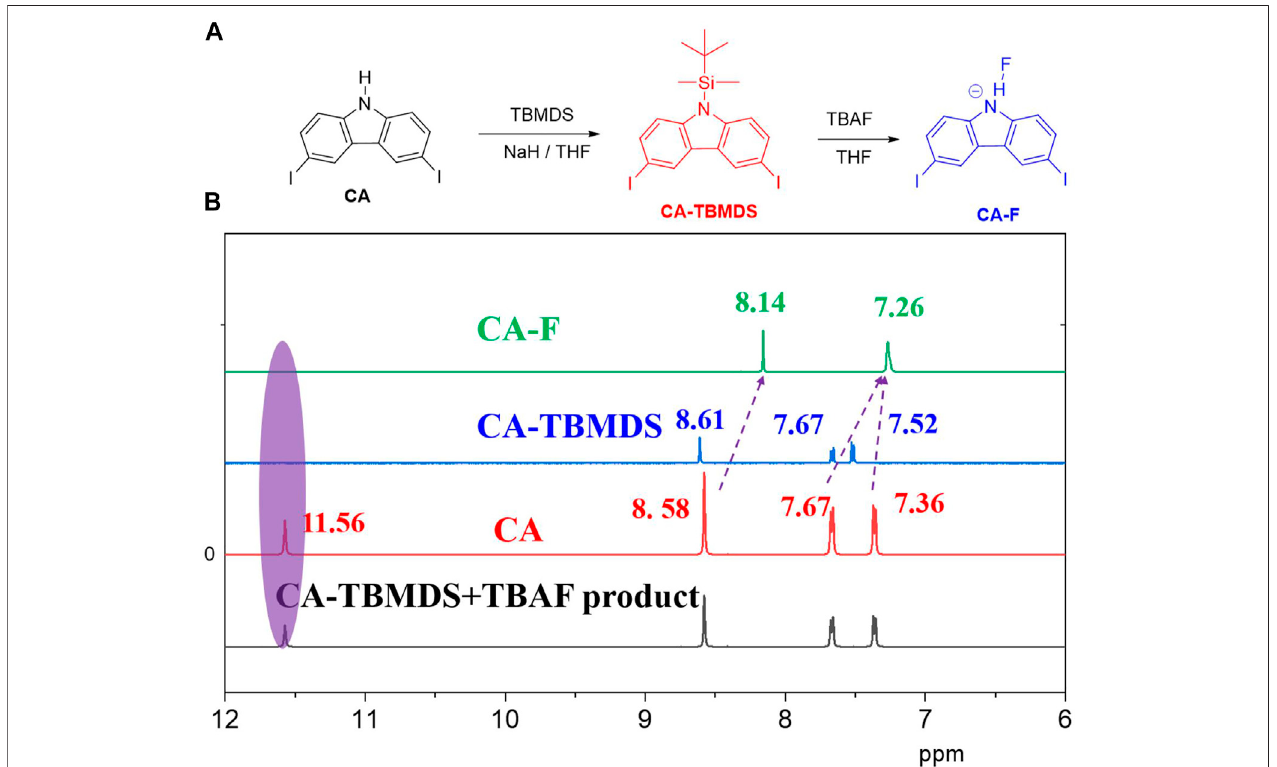
FIGURE 2 | (A) Synthesis of CA-TBMDS, and reaction between CA-TBMDS and fl uoride anion. (B) Partial 1 H NMR titration spectra of CA and CA-TBMDS before and after adding fl uoride anion (4 eq.) in DMSO- d 6 .